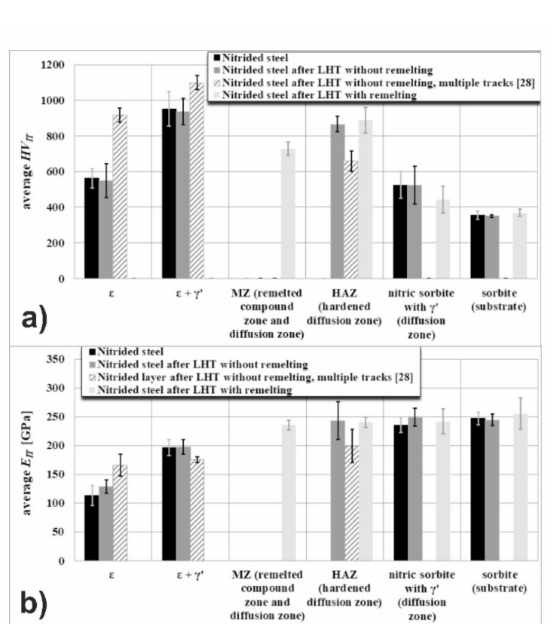
Figure 17. Averaging values of Vickers hardness HV IT ( a ) and indentation modulus E IT ( b ) and their standard deviations, determined in the di ff erent zones of the